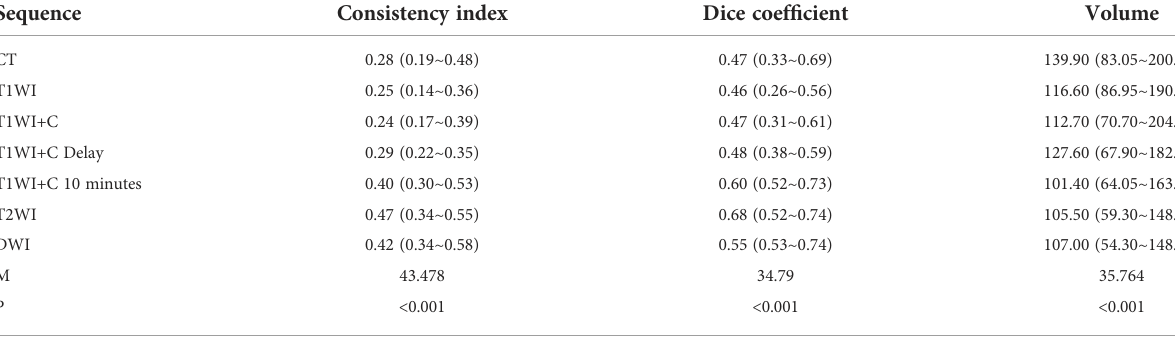
TABLE 2 Descriptive results of mean volumes, CI, and DC and results of Friedman test.